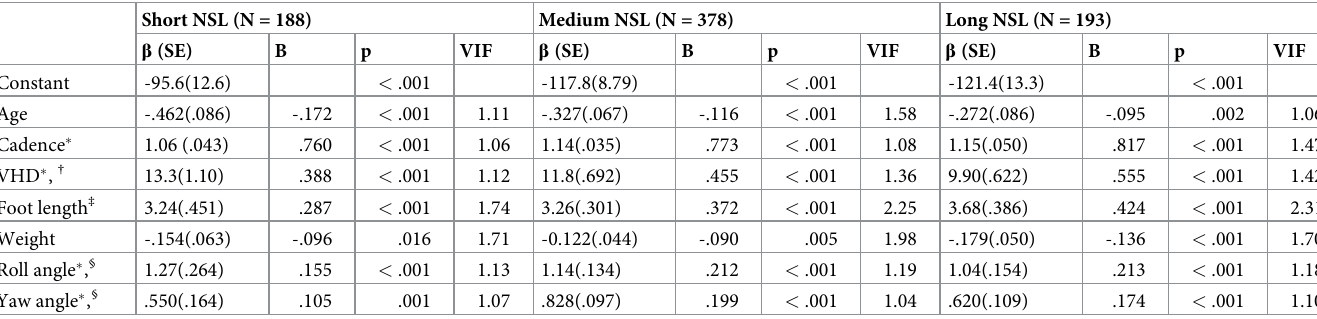
Table 4. Development of the normalized step length subgroup-specific gait speed estimation models. Short NSL (N = 188)